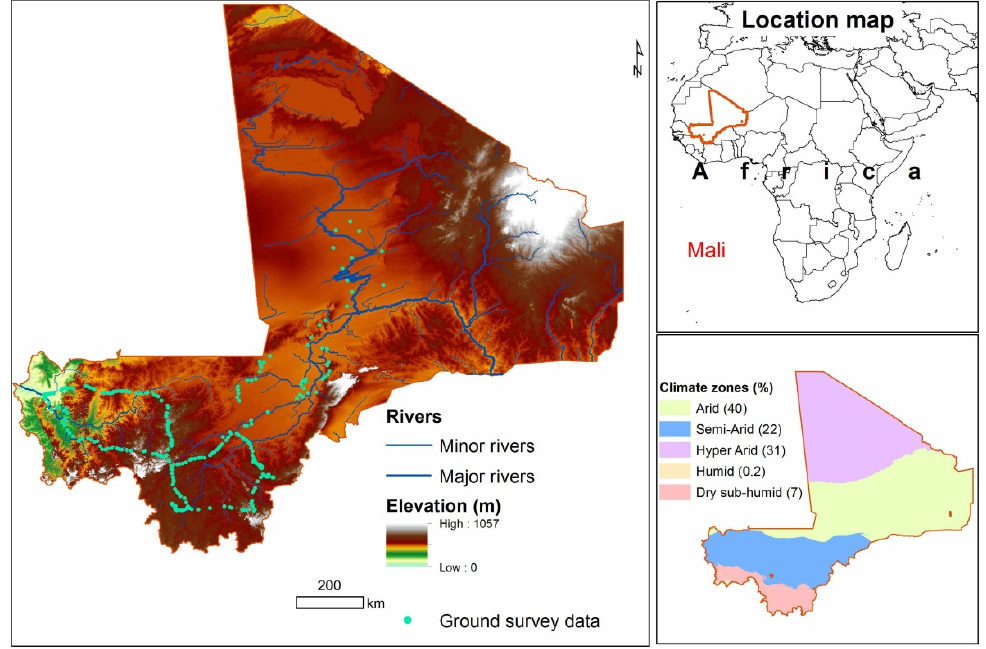
Figure 1. Location map of Mali with major rivers, Ground survey data and climate zones.